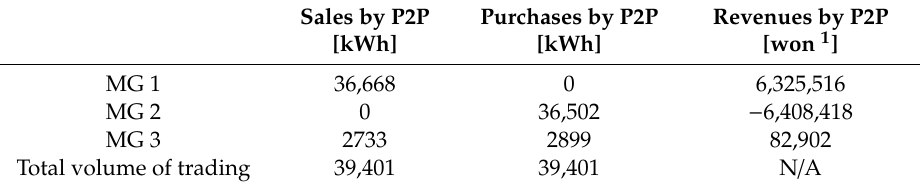
Table 2. Comparisons of total power supply costs and total power purchases from utility in each scenario.